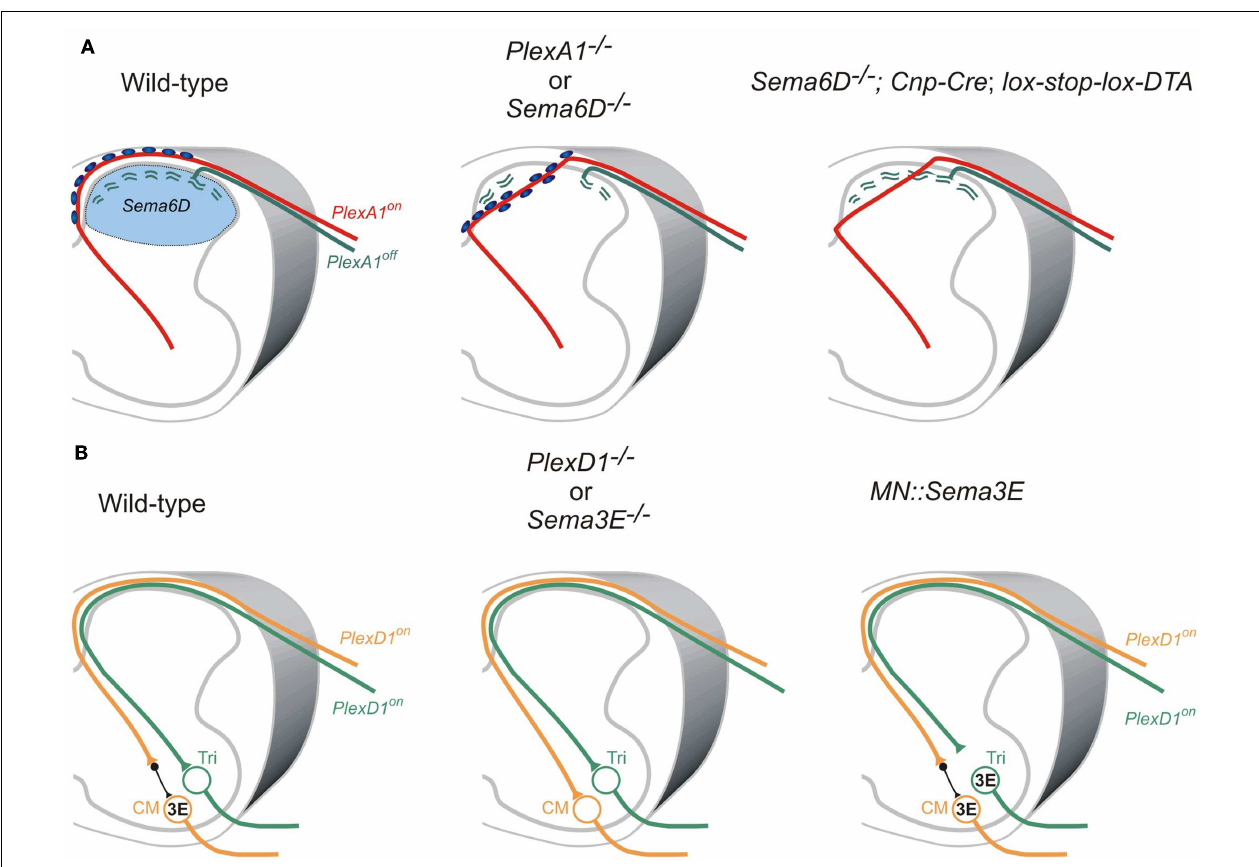
wild-type, PlexD1 , and Sema3E mutant mice as well as motor neuron-specific Sema3E -expressing mice (Pecho-Vrieseling et al., 2009). Motor neurons innervating triceps (Tri) muscle receive monosynaptic inputs fromTri sensory afferents, whereas cutaneous maximus (CM) motor neurons lack monosynaptic inputs from CM sensory afferents. Sema3E is expressed by CM motor neurons but notTri motor neurons. PlexD1 is expressed by ∼ 80% of CM proprioceptive sensory neurons, and ∼ 50% ofTri proprioceptive sensory neurons. Absence of Sema3E-PlexD1 signaling causes aberrant monosynaptic sensory-motor connections between CM sensory and CM motor neurons. Ectopic expression of Sema3E inTri motor neurons reduces monosynaptic connections betweenTri afferents andTri motor